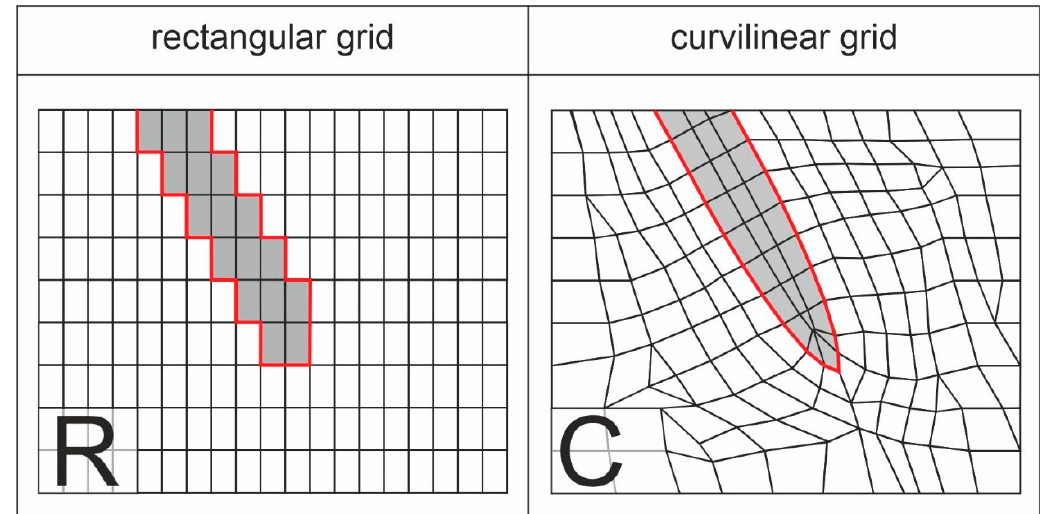
Figure 15. Image showing the rectangular ( R ) and curvilinear ( C ) grid geometries and their interaction with the surrounding rock mass. While the fault cells in the rectangular approach tend to interlock with the surrounding, stronger host rock, the edges of the fault cells in the curvilinear representation form a surface almost parallel to the fault plane. Furthermore, the curvilinear representation ends in a pointed geometry while the rectangular fault ends in as a block of cells.